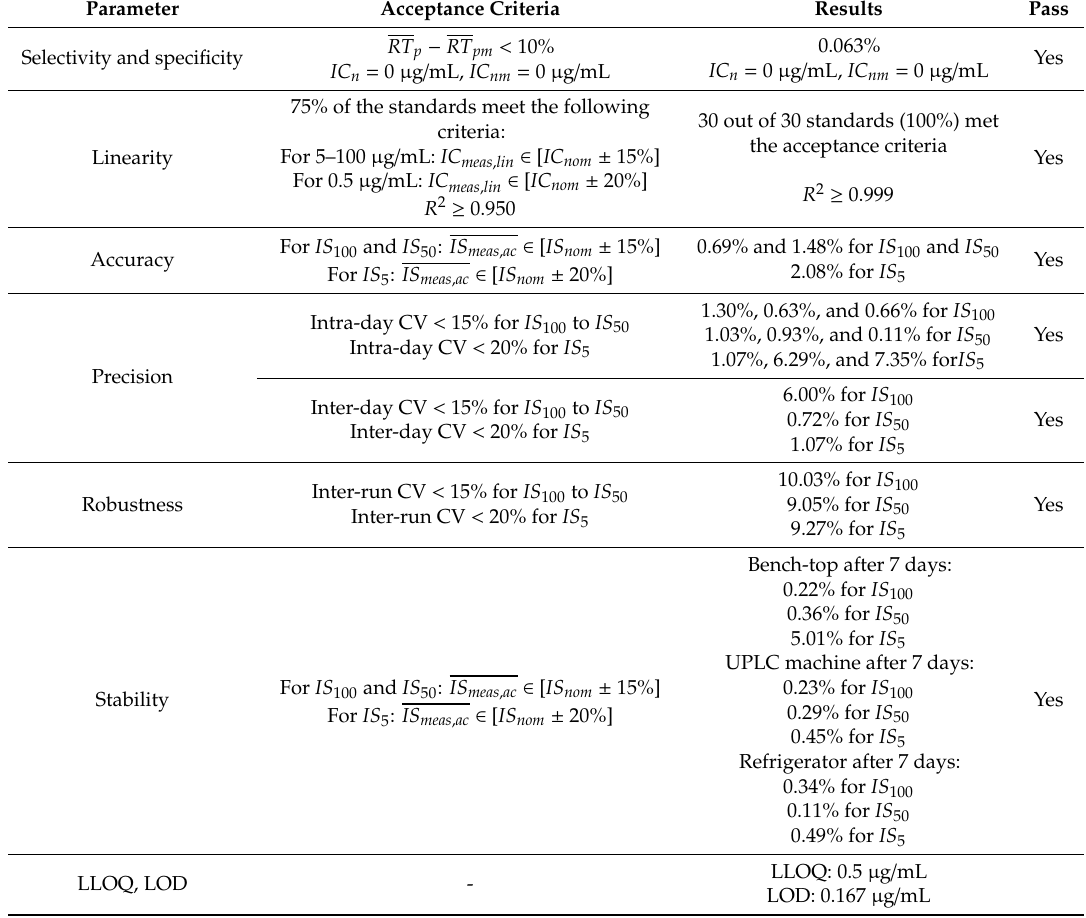
Table 1. Predefined acceptance criteria and the results obtained from the UPLC validation for IVRT method [11].